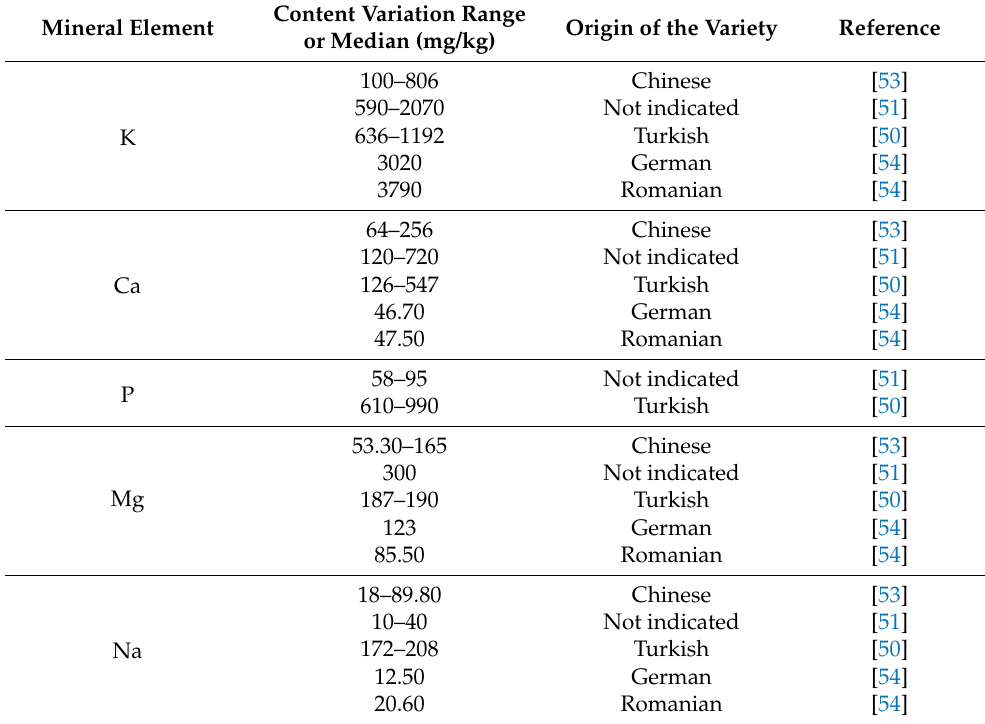
Table 4. The mineral composition of sea buckthorn fresh